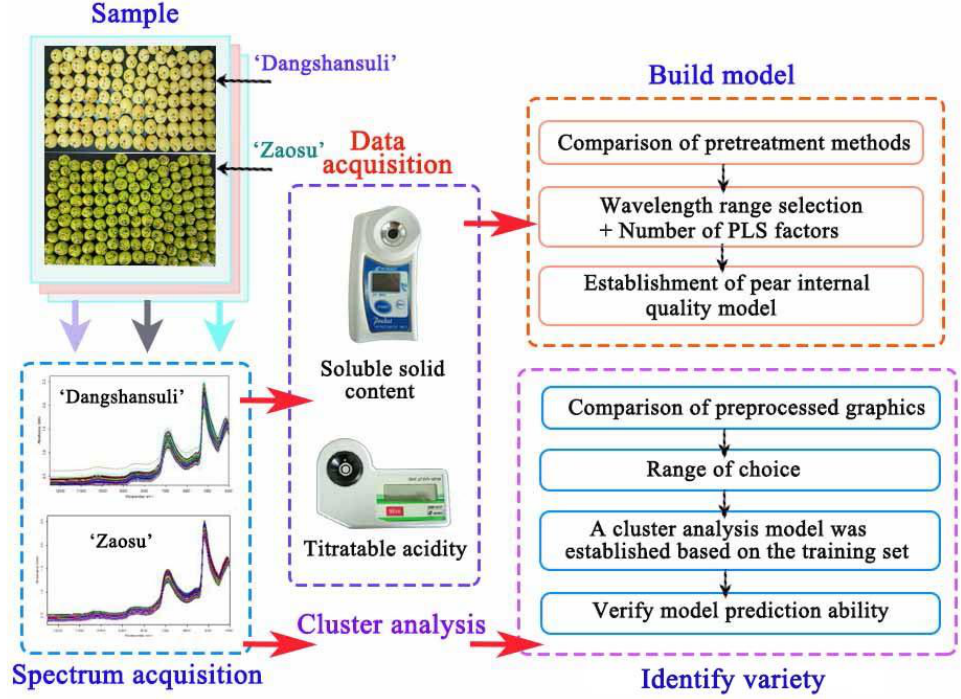
Figure 1. Flow chart of the test and modeling process.